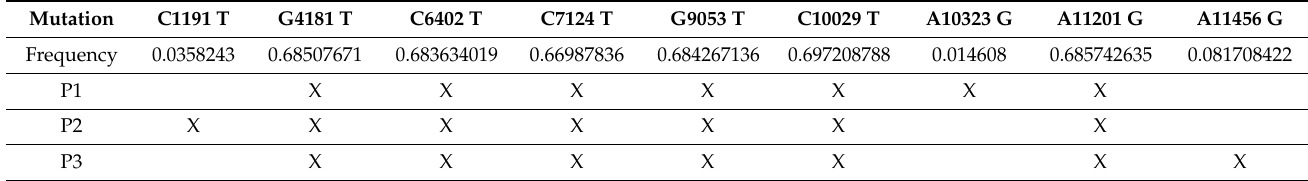
Table 5. Case-B ORF1a Mutations and Frequencies. Mutations observed within ORF1a gene between all outbreak samples. “X” denotes the presence of the mutation. The frequency of each mutation is listed below its designation. P1–P3 imply CoV-2 extracted from outbreak patient-1 to patient-3.